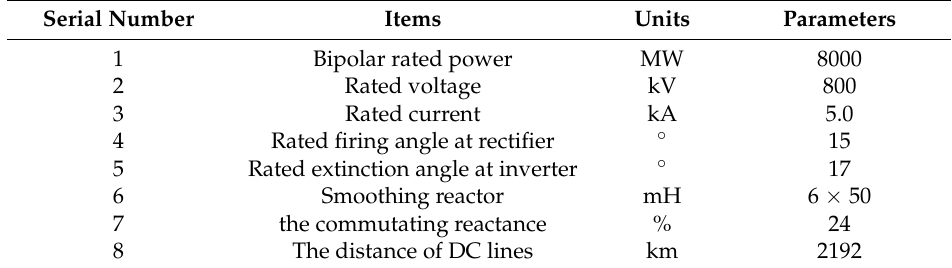
Table 1. The main parameters of Tianzhong ± 800 kV ultra high voltage direct current (UHVDC).